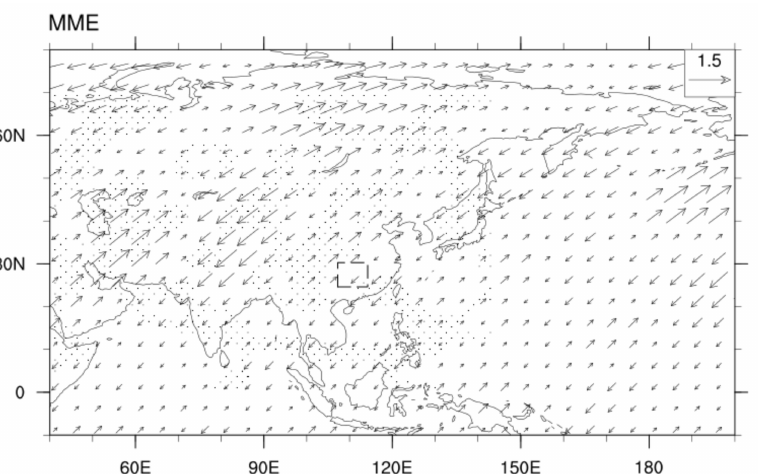
Figure 8. The 200 hPa wind field difference between the peak years and valley years, unit: mm/s, the dotted area indicates that the meridional wind passed the 95% significance